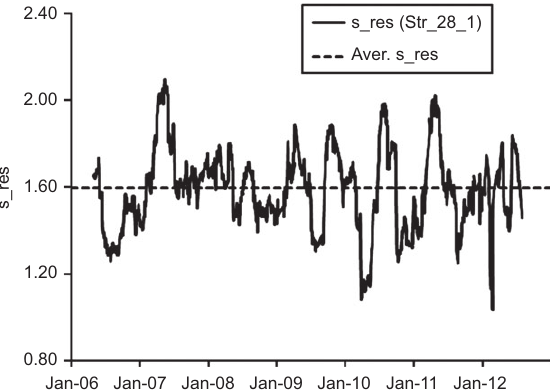
Figure 8 Residual errors for the first